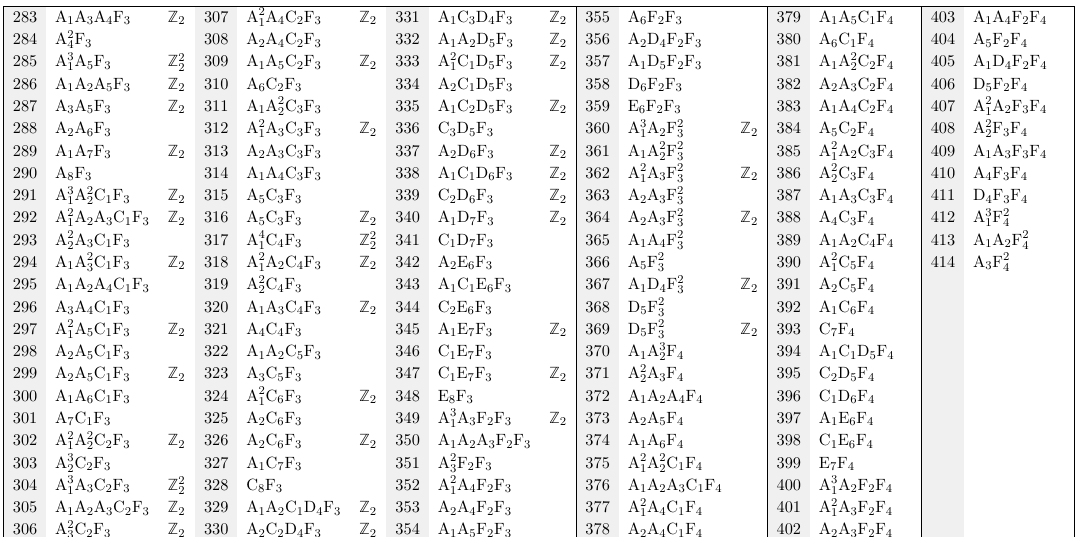
Table 5 . Algebras of maximal rank for the heterotic Z 2 triple.